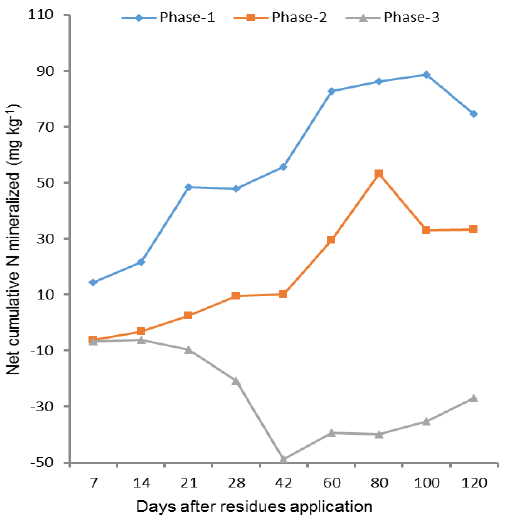
Figure 2. The mineralization–immobilization turnover of added plant residues representing three phases during 120 days incuba- tion.